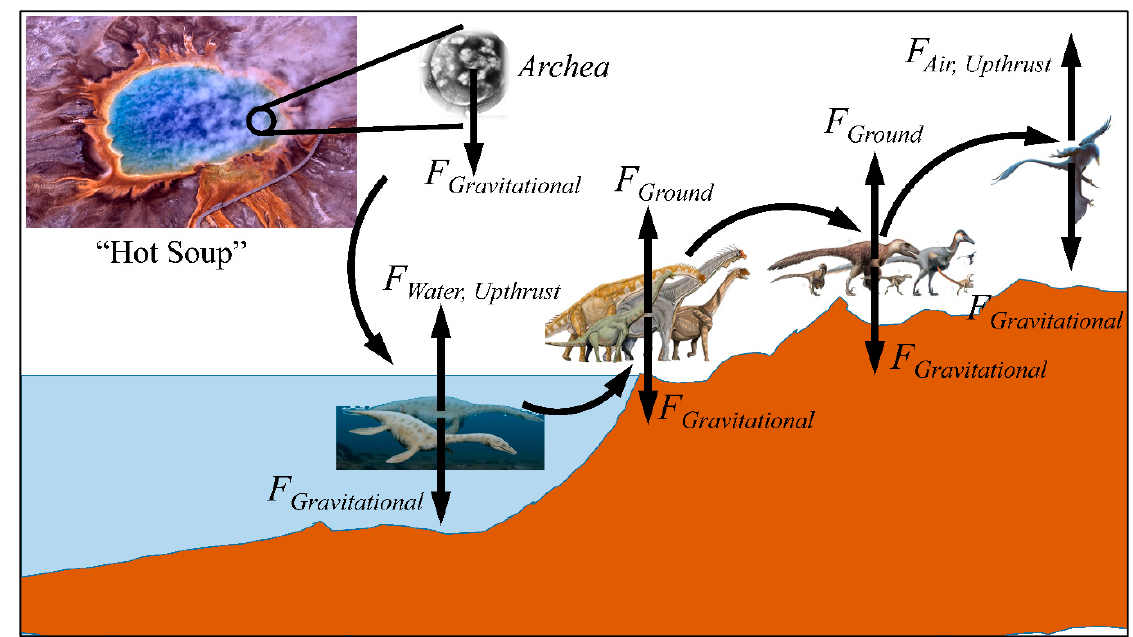
Figure 2. A diagrammatic representation of the evolution on Earth and the force of gravity acting on all stages of evolving life. As organisms evolved from the primary microorganisms to the formation of life in water, the transition to land and then air was constantly under the effect of gravitational forces ( Legend : the images of the “hot soup”, archaea and dinosaurs were obtained from https://en.wikipedia.org/wiki/Dinosaur, under the CC BY 2.0 license, Accessed on 3 October